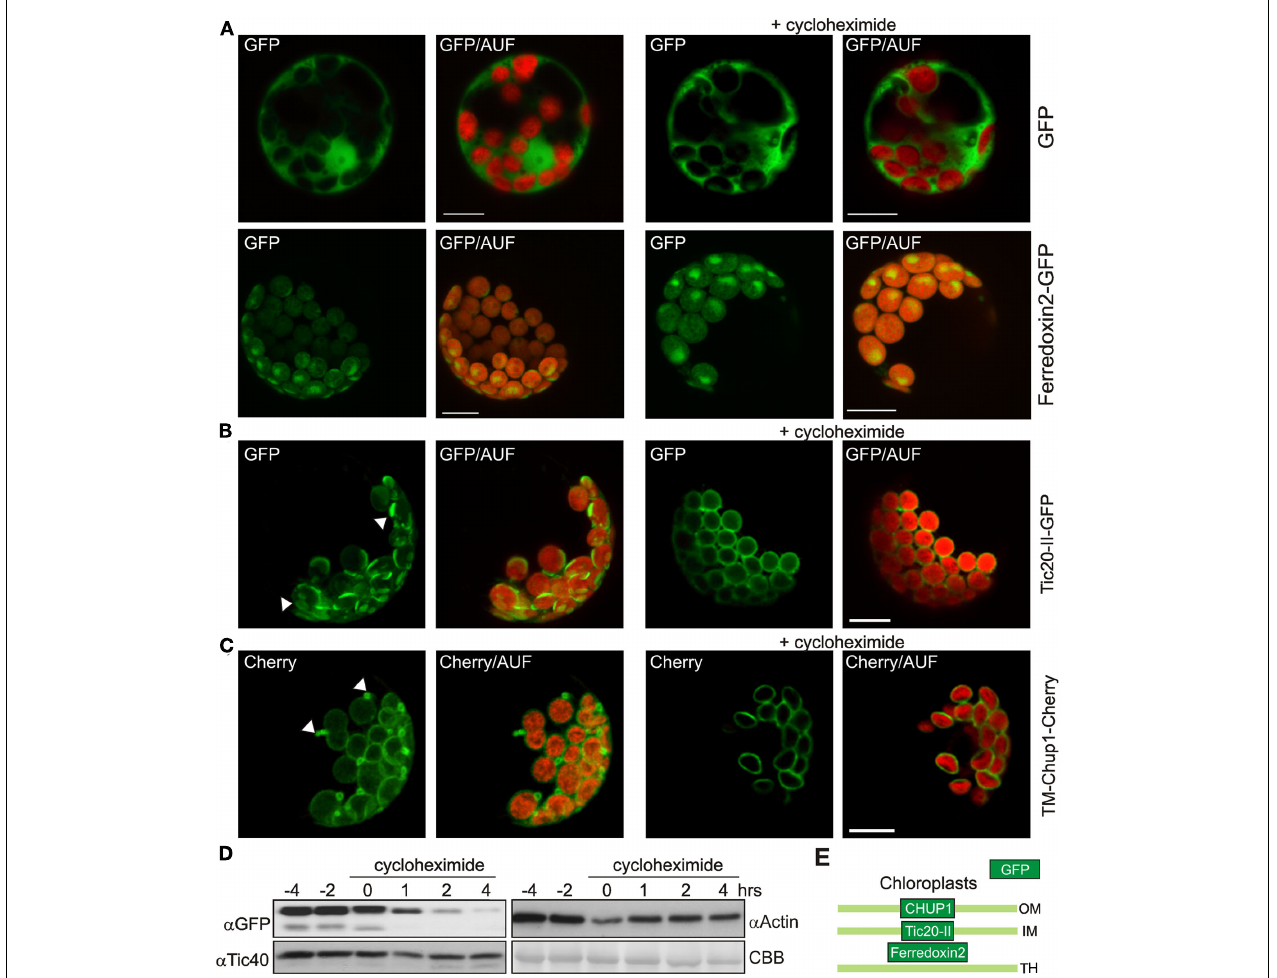
envelope protein CHUP1 (TM-CHUP1) was fused to Cherry and expressed in A. thaliana mesophyll protoplasts under control of a 35S promoter (left panels).Two hour prior to analysis one set was treated with cycloheximide (right panels). Cherry fluorescence (cherry), and overlays of cherry and chlorophyll autofluorescence (Cherry/AUF) of representative protoplasts are shown. Images are maximum projections of optical sections. In (B,C) , white arrowheads point to membrane deformations in the absence of cycloheximide. Scale bars represent 10 μ m. (D) Western blot analysis of protoplasts overexpressing at Tic20-II–GFP before and after addition of cycloheximide (at 0h). Coomassie brilliant blue stained RUBISCO (large subunit) as loading control (CBB). (E) The localization of the proteins used in this figure is shown schematically (OM, outer membrane; IM, inner membrane;TH, thylakoid